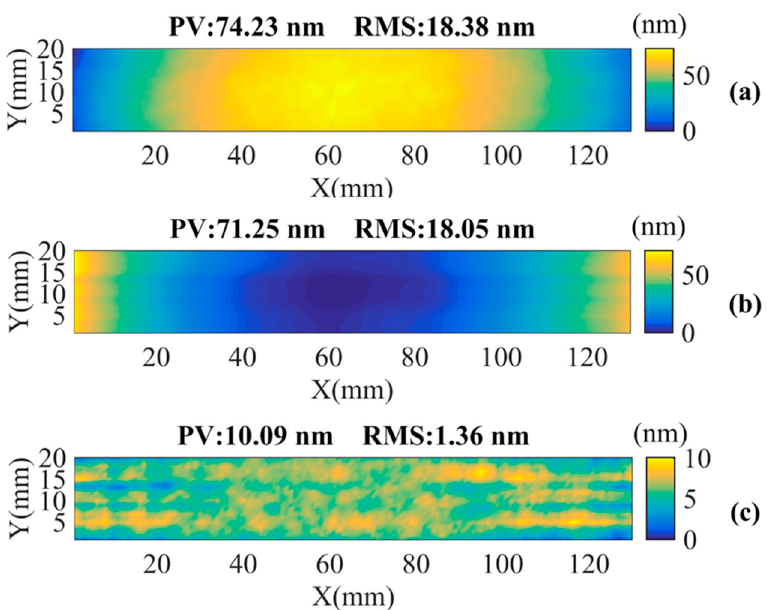
Figure 11. Simulated correction results. ( a ) Shape before correction. ( b ) Added thickness profile for the three-line correction. ( c ) Shape after the three-line correction.